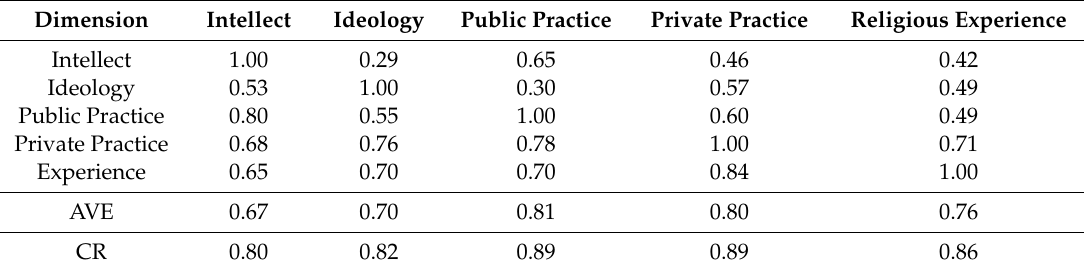
Table 8. Results for CRS-10 with five dimensions: Correlations, squared correlations, AVE, and CR.